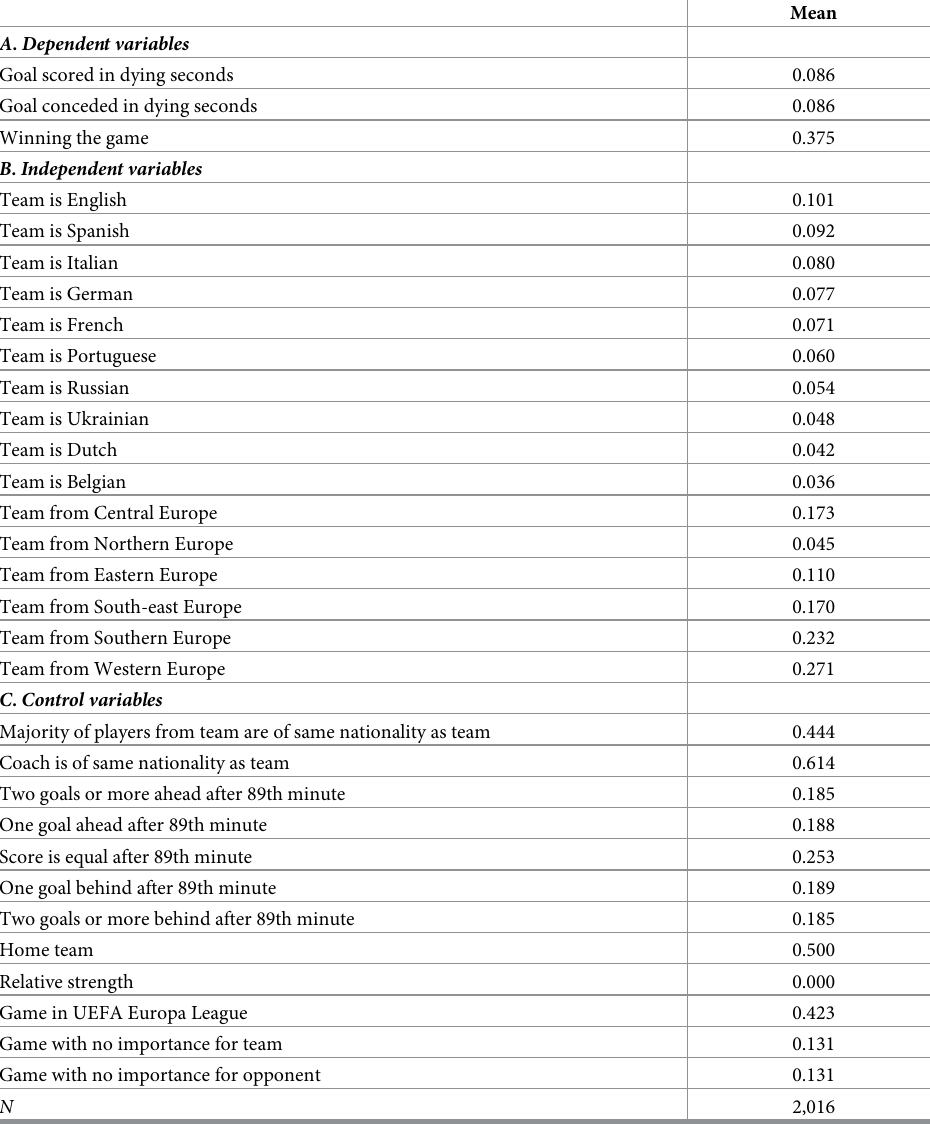
Table 1. Data: Summary